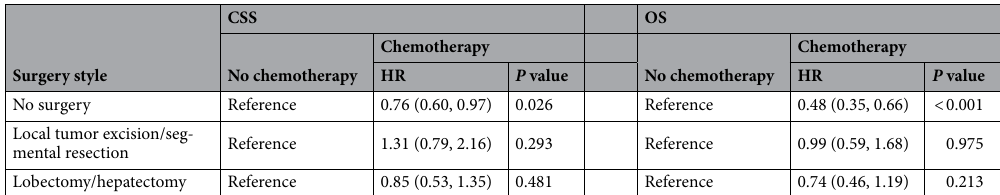
Table 3. Role of chemotherapy related to cancer-specific survival (CSS) and overall survival (OS) in stratified Cox regression analysis. Adjustment factors: Age; Sex; Race; Marital status; Insured status; Year at diagnosis; Grade; Tumor size; AJCC stage; radiotherapy.